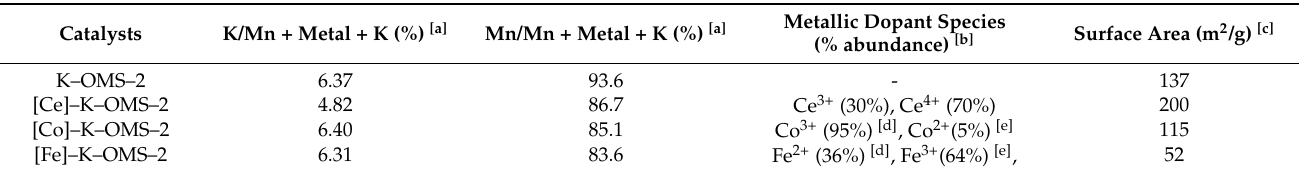
Table 6. Properties and characteristics of [M]–K–OMS–2 and K–OMS–2 oxides used in the degradation of ozone. Data were extracted from [106].